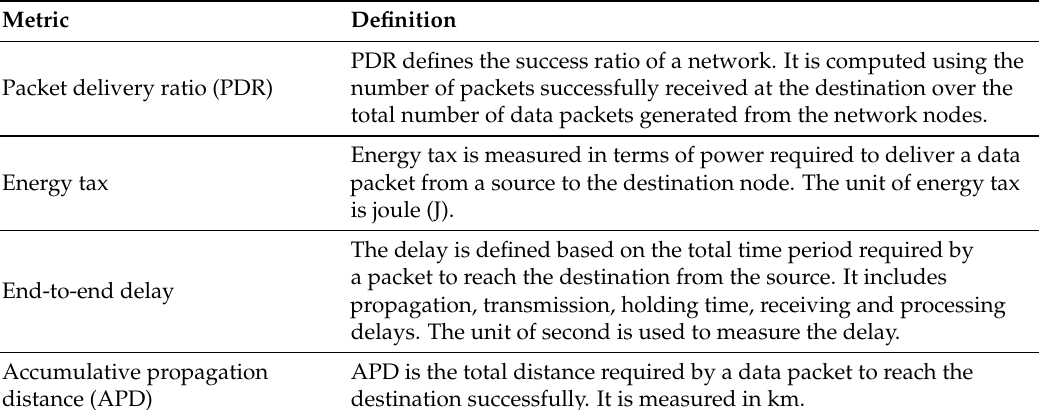
Table 4. Performance evaluation parameters.